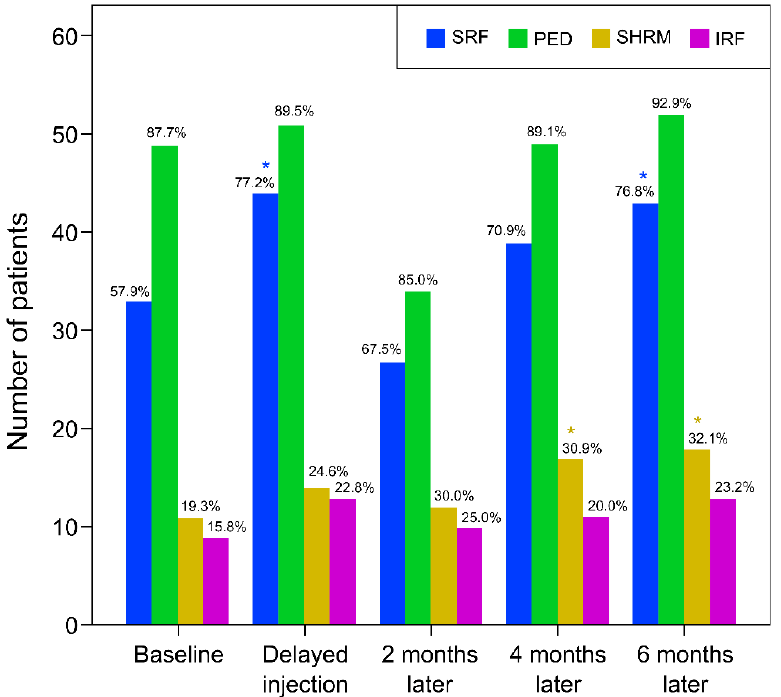
Figure 2. Bar chart displaying changes in structural OCT findings during the follow-up period. The height of the bars indicates the number of patients who showed the corresponding OCT finding. The percentage shown above the bar represents the percentage of patients who had the finding among the patients observed at that time. The proportion of patients with OCT findings of SRF, PED, and IRF increased after the time of delayed injection, and when the treatment was restarted, and the figure decreased 2 months after the treatment delay, but eventually gradually increased 4 and 6 months after the delay. The proportion of patients with SHRM gradually increased over time from baseline. OCT, optical coherence tomography; SRF, subretinal fluid; PED, pigment epithelial detachment; SHRM, subretinal hyperreflective material; IRF, intraretinal fluid. * Statistically significant compared to baseline.